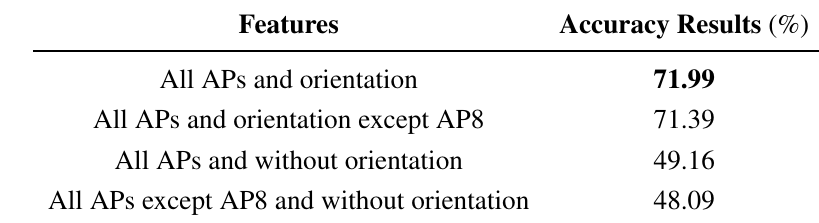
Correctly classified instances for different features selection using boosting with C4.5.